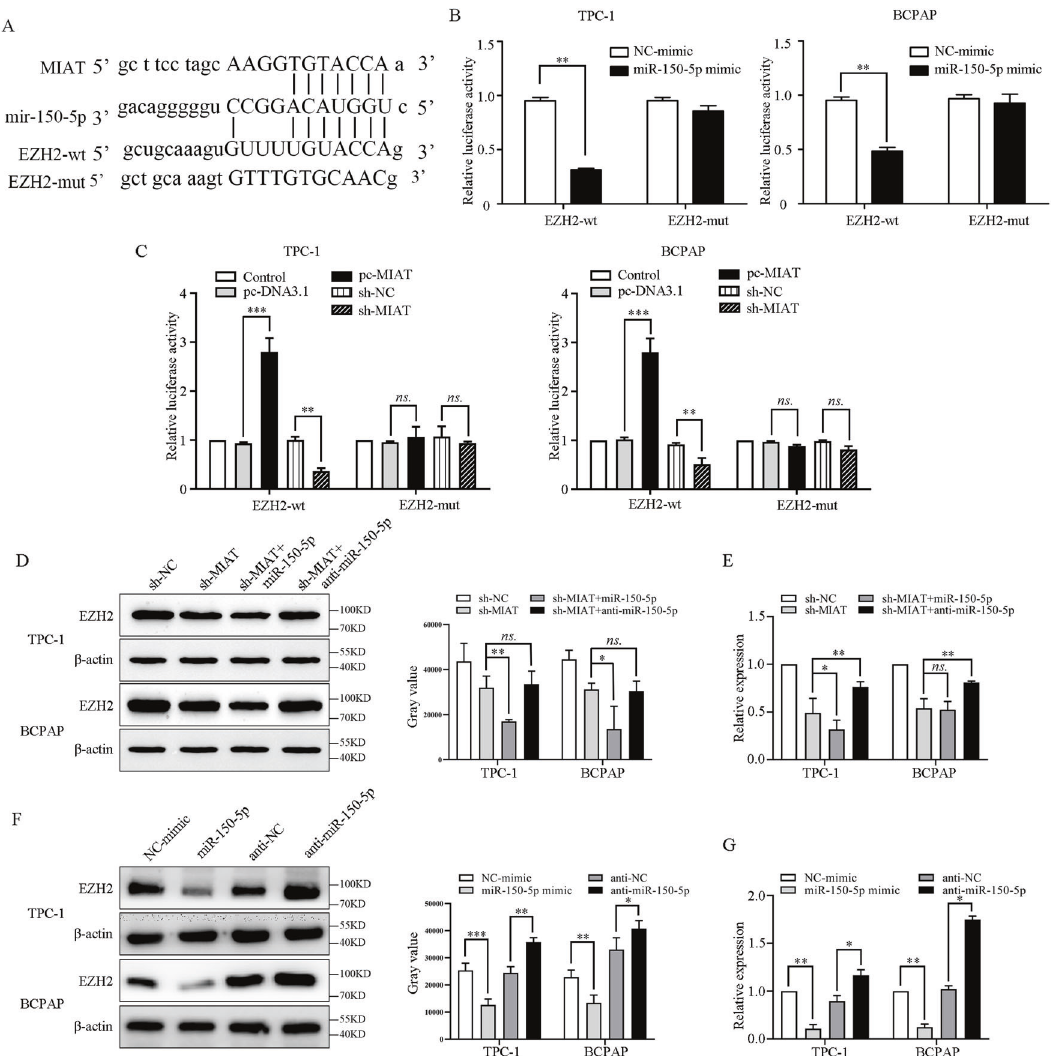
Fig. 7 MIAT regulates EZH2 expression by sponging miR-150-5p in papillary thyroid cancer. A The binding sites of miR-150-5p and EZH2, and the mutant sequence of EZH2based on the binding region. B miR-150-5p mimic suppressed the luciferase activity of EZH2 wild-type vector in TPC-1 and BCPAP cells. C pc-MIAT enhanced and sh-MIAT decreased the luciferase activity of EZH2 wild-type vector in TPC-1 and BCPAP cells. D Protein levels of EZH2 in TPC-1 and BCPAP cells were determined by western blot when regulate the expression of MIAT. E Protein levels of EZH2 in TPC-1 and BCPAP cells were determined by western blot when regulate the expression of miR-150-5p. F Relative expression of EZH2 in TPC-1 and BCPAP cells transfected with sh-NC, sh-MIAT, sh-MIAT + miR-150-5p, and sh-MIAT + anti-miR-150-5p by PCR. G Relative expression of EZH2 in TPC-1 and BCPAP cells transfected with NC-mimic, miR-150-5p mimic, anti-NC, and anti-miR-150-5p. * P < 0.05, ** P < 0.01, *** P < 0.001 compared with control cells, n.s. non-signi fi cant, using two-tailed t -test